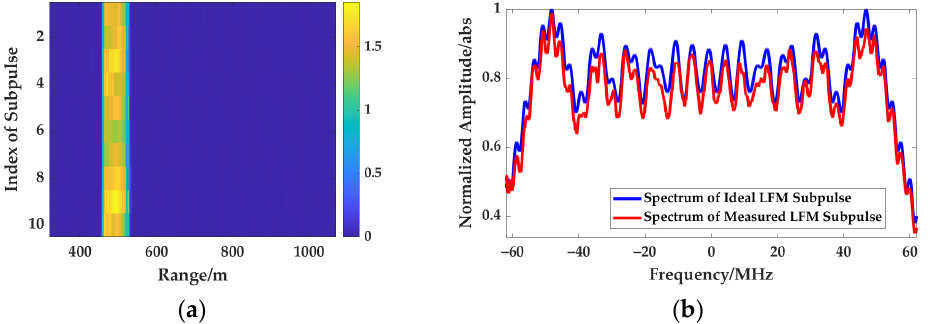
Figure 15. Subpulse echoes collected by the high-resolution coherent radar: ( a ) time-domain echoes;